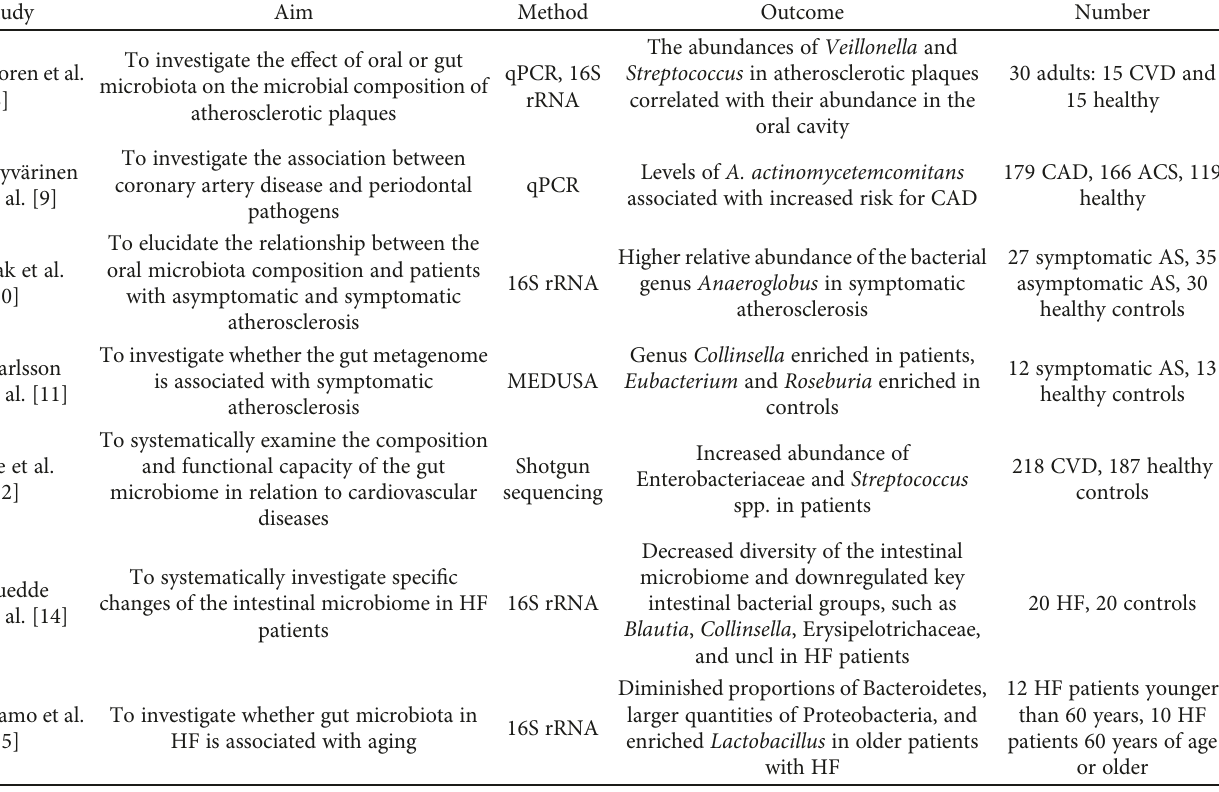
Table 1: Summary of human trials studying the association between gut microbiome and cardiovascular